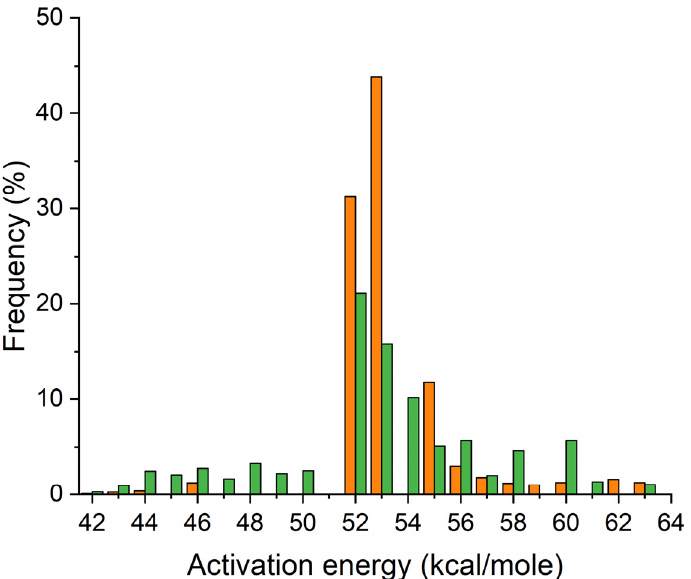
Figure 7. Discrete activation energy spectra for original (green) and extracted (orange) oil shale samples.